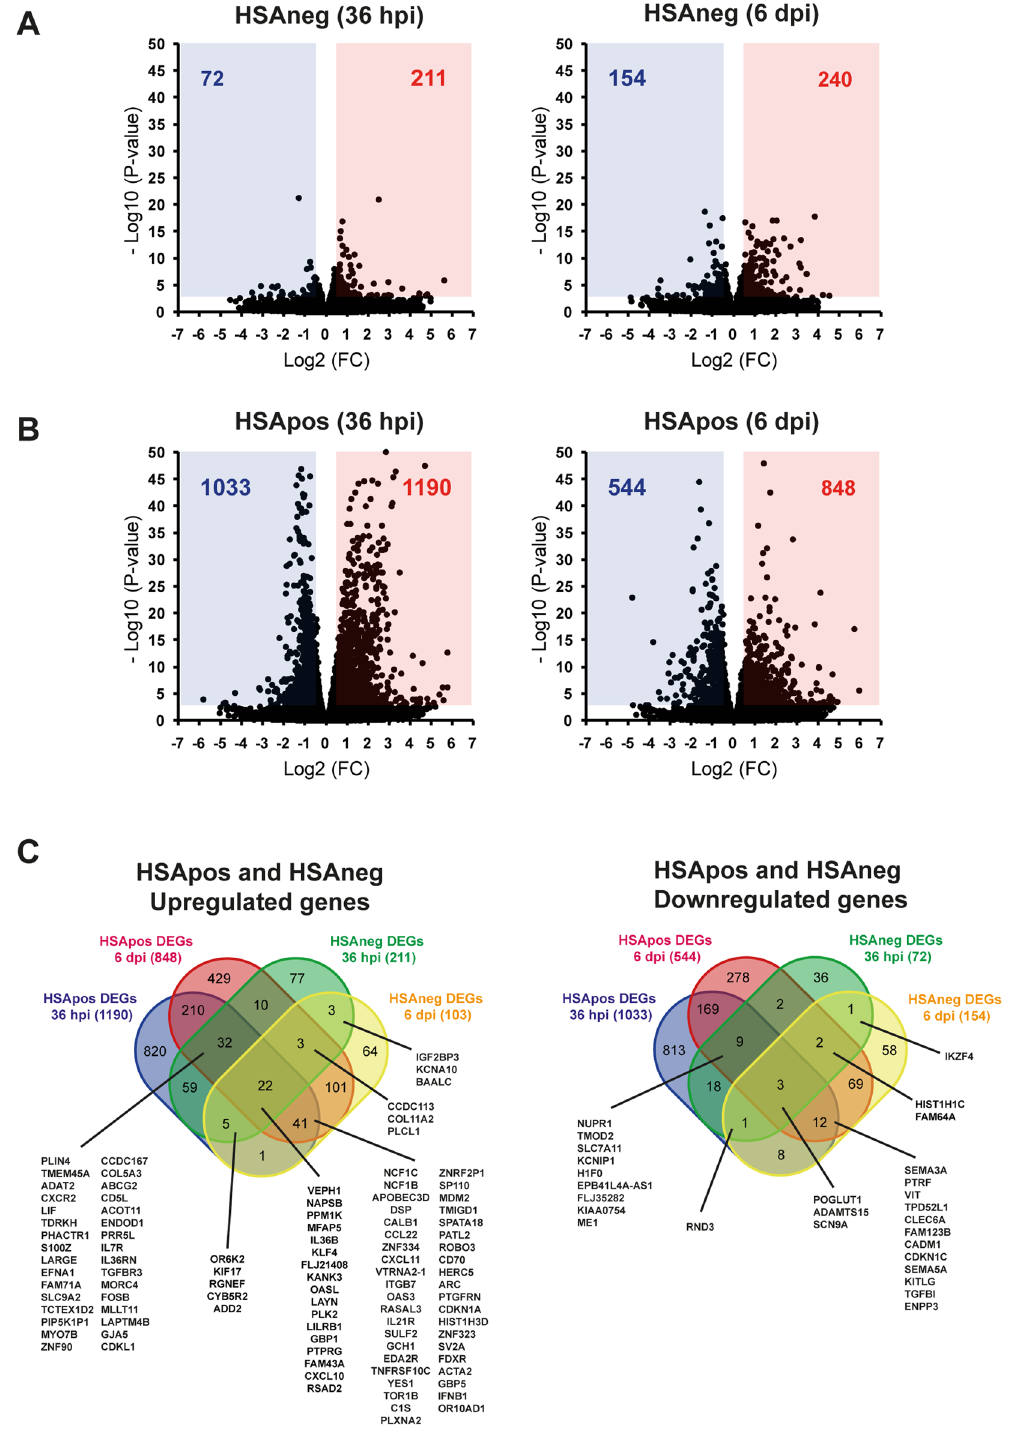
Figure 2. HIV-1 induces major changes in the MØ transcriptome very early after productive infection. Volcano plot analyses indicate that HSAneg MØ ( A ) are weakly affected by HIV-1 compared to the HSApos cell population ( B ) in RNAseq samples at 36 hpi and 6 dpi. Data are presented as Log2 Fold-Change (Log2 FC) of fragments per kilobase of transcript per million mapped reads (FPKM) with associated p values calculated from four independent experiments. ( C ) A comparison of Differentially Expressed Genes (DEGs) in HSApos and HSAneg MØ using a Venn diagram analysis shows that the regulation of the cellular environment is time-dependent in infected and bystander cells. The numbers indicate the total number of genes in each area. Diagrams were generated using the following tool: http://bioinformatics.psb.ugent.be/webtools/Venn/. The complete list of DEGs is supplied in the Supplementary Table